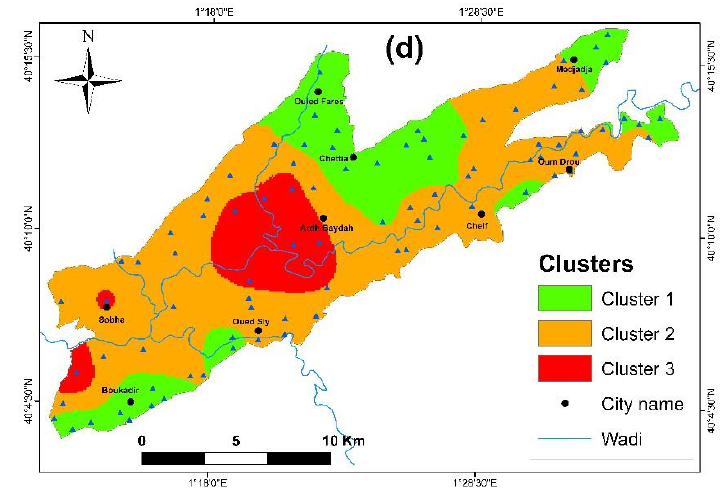
Figure 13. Spatial variation map of: ( a ) Factor 1; ( b ) Factor 2; ( c ) Factor 3; ( d ) Clusters in the WMCP.